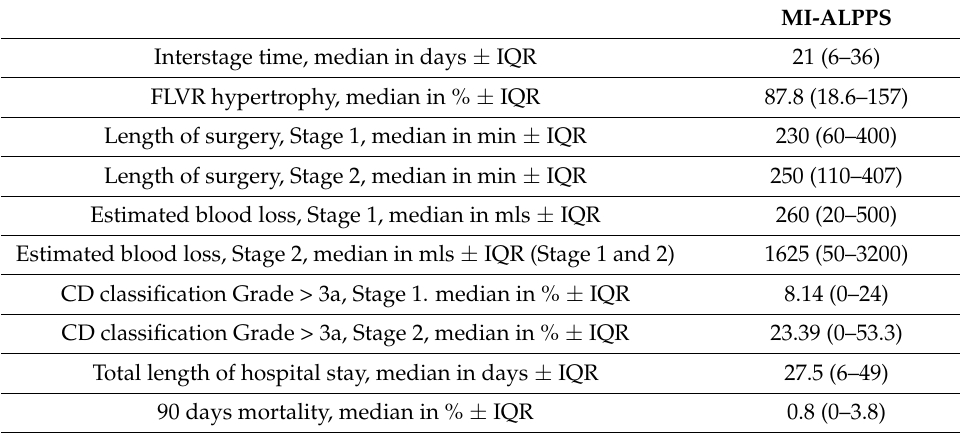
Table 5. Details of perioperative data